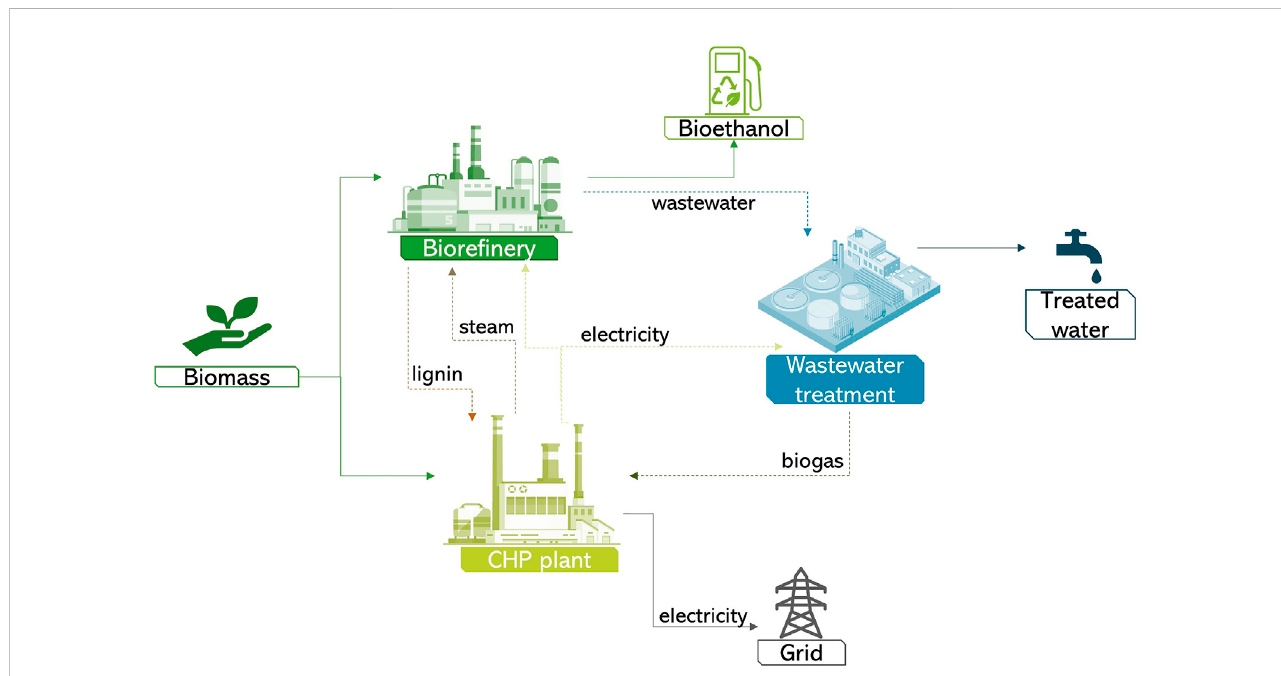
FIGURE 6 Eco-Industrial Park diagram for a three-plant symbiotic system. Based on data from Tan et al.